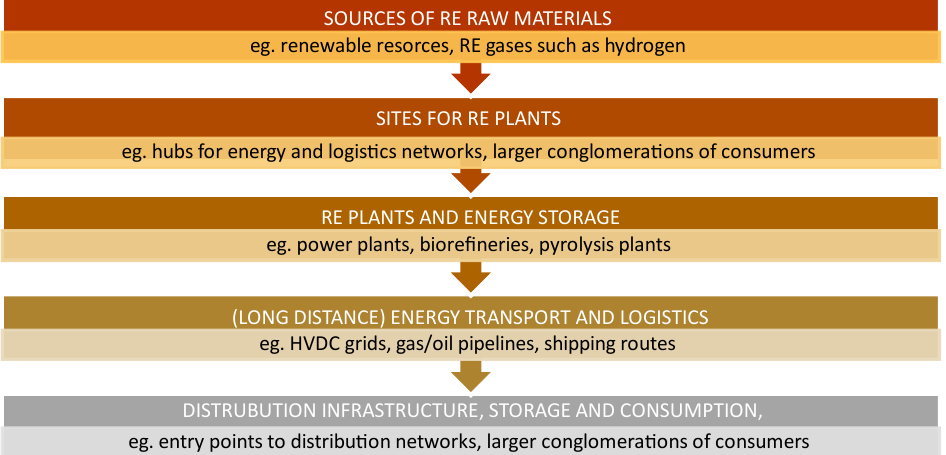
Figure 20. Value chain for transnational renewable energy projects. Source: own study based on [90].